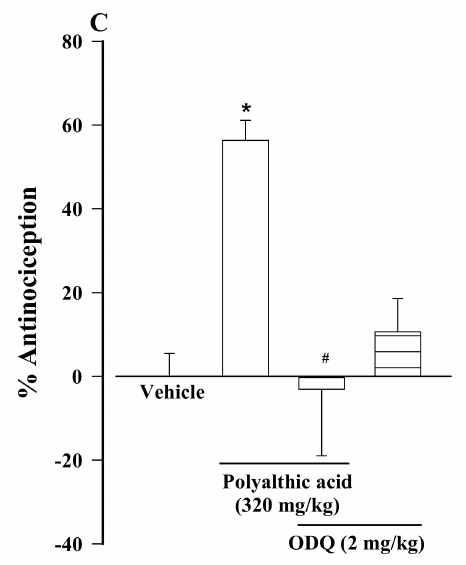
Figure 3. Evaluation of the participation of opioid receptors (with naltrexone), 5HT1,5 receptors (with methiothepin), and cyclic GMP (with ODQ) in the antinociceptive activity of polyalthic acid (320 mg/kg) in rats submitted to 1% formalin test. Naltrexone, methiothepin and ODQ were intraperitoneally injected into the animals 10 min before administering polyalthic acid. The effect is shown of the pretreatment with ( A ) naltrexone (1 mg/kg, i.p.), ( B ) methiothepin (0.1 mg/kg, i.p.) and ( C ) ODQ (2 mg/kg, i.p.). Data are expressed as the mean number of flinches ± SEM ( n = 6). * p < 0.0001 vs. the vehicle group; # p < 0.001 vs. polyalthic acid in the absence of